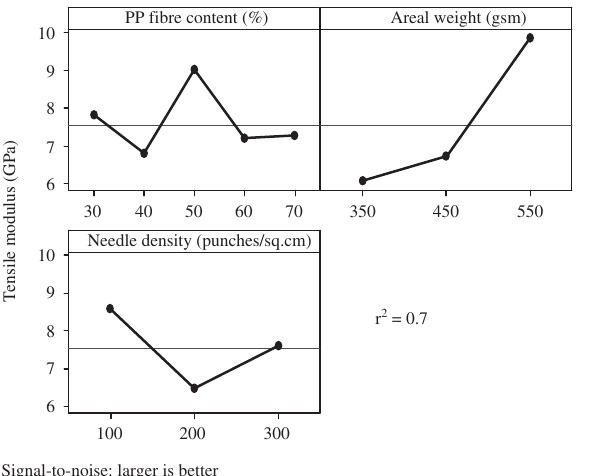
Figure 3: Tensile properties of composites.